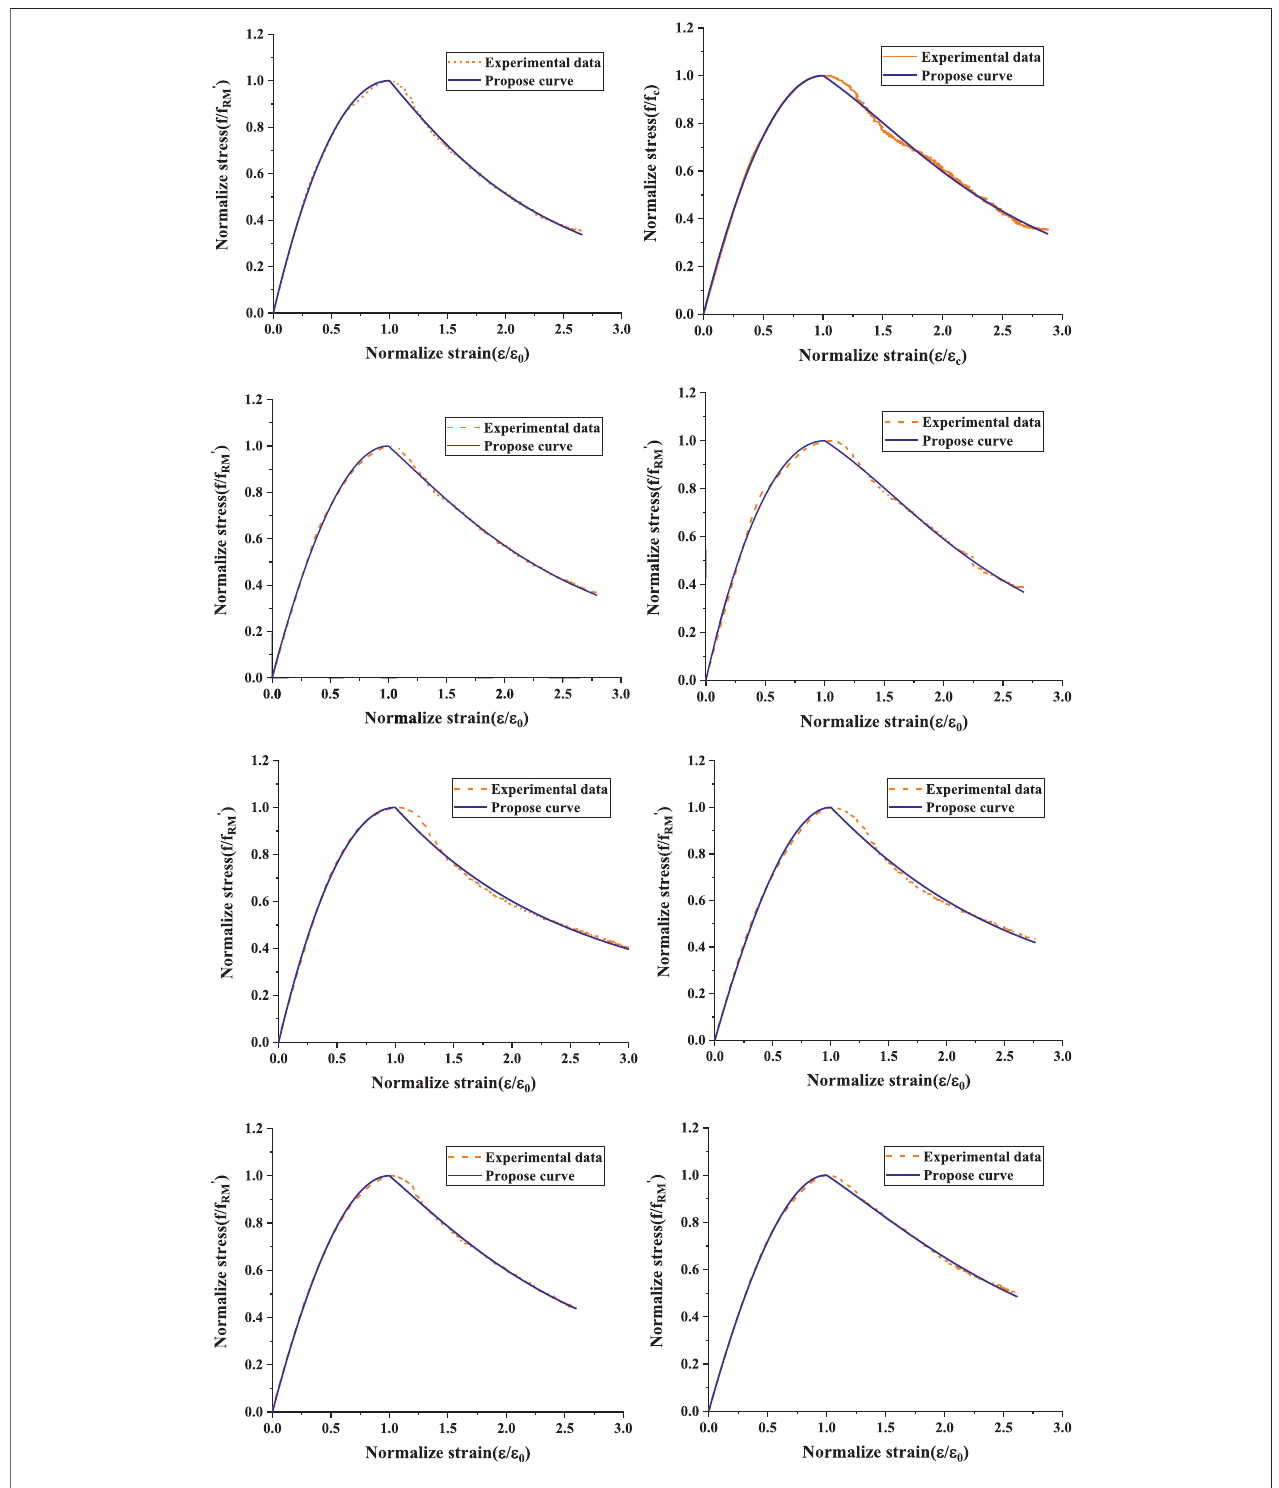
FIGURE 10 | Comparison between stress-strain model and experimental results.